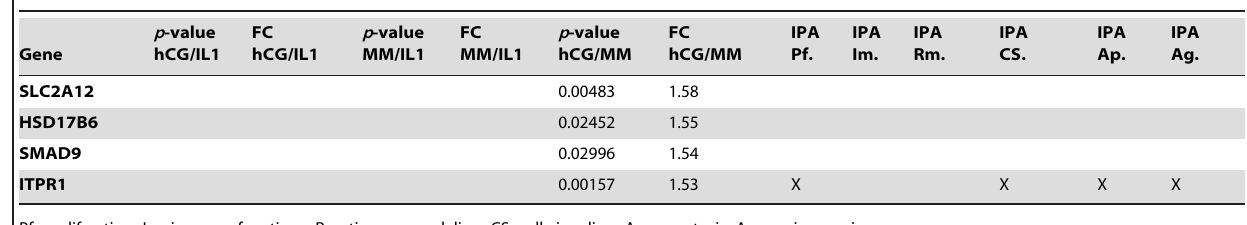
Pf, proliferation; Im, immune functions; Rm, tissue remodeling; CS, cell signaling; Ap, apoptosis; Ag, angiogenesis a´/aˆ Real-time PCR/ELISA validation performed Genes up-regulated after in vitro treatment of human endometrium stromal cells